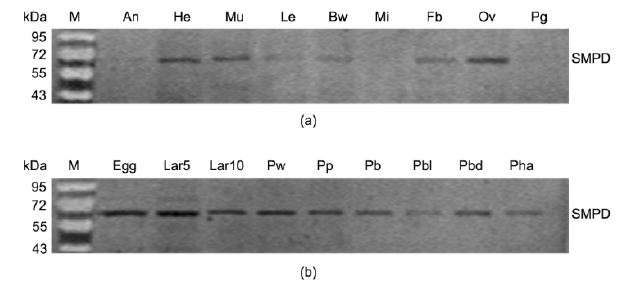
Fig 7 . Expression levels of SMPD proteinat different tissues(a) and different development stages(b) determinedusing prepared polyclonal antibody. The different tissues include: antenna (An), head (He), muscle (Mu), leg (Le), body wall (Bw), midgut (Mi), fat body (Fb), ovary (Ov) and poison gland (Pg) of the queen. Likewise, the differentstages include: egg, larvae atday 5, larvae atday 10, Pw, Pp, Pb, Pbl, Pbd and Pha